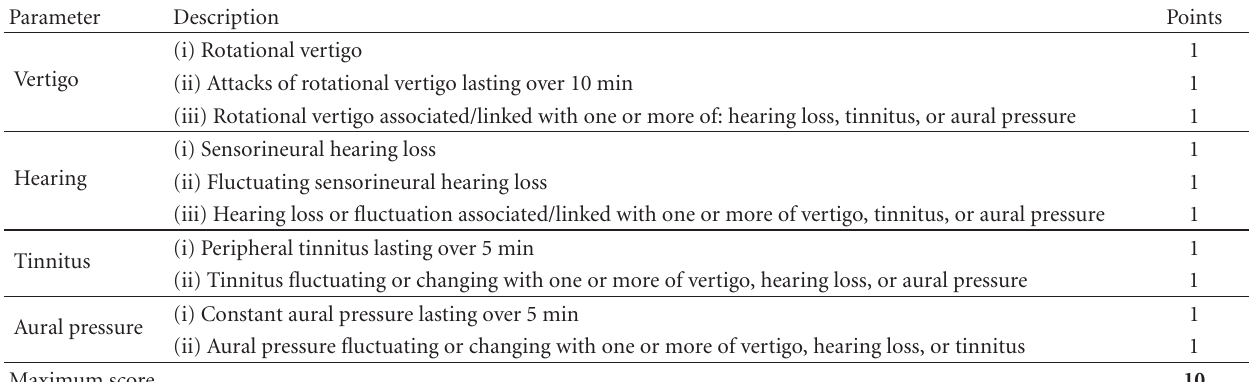
Table 2: The point system of the Gibson score (adapted from[5, page